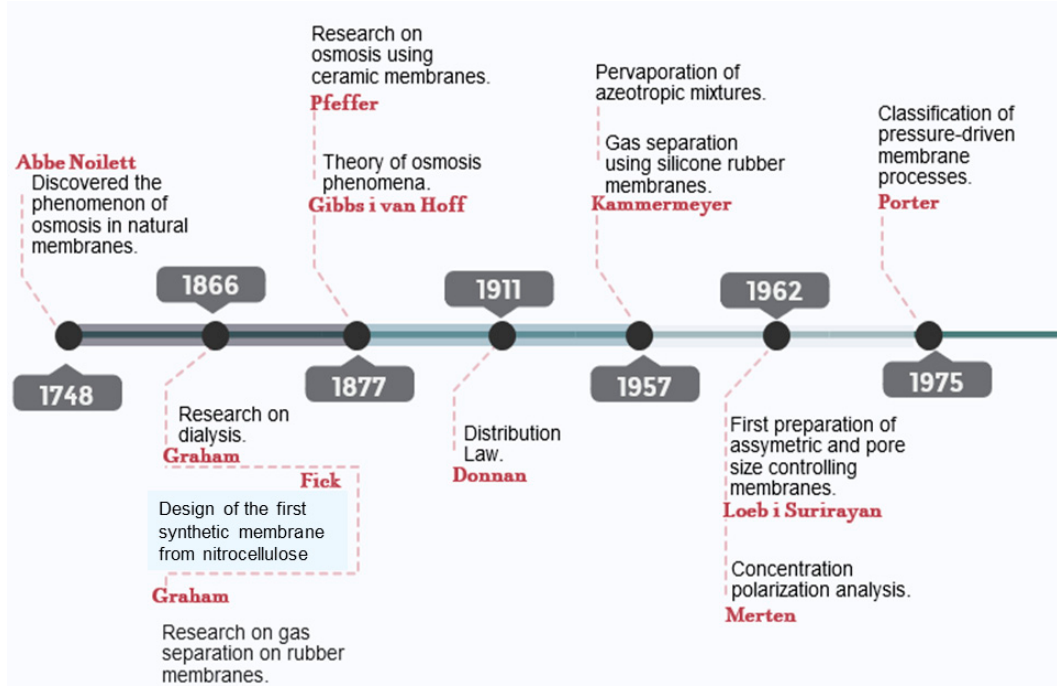
Figure 3. Milestones on the development of membranes from its early beginnings until the 1990s [3].